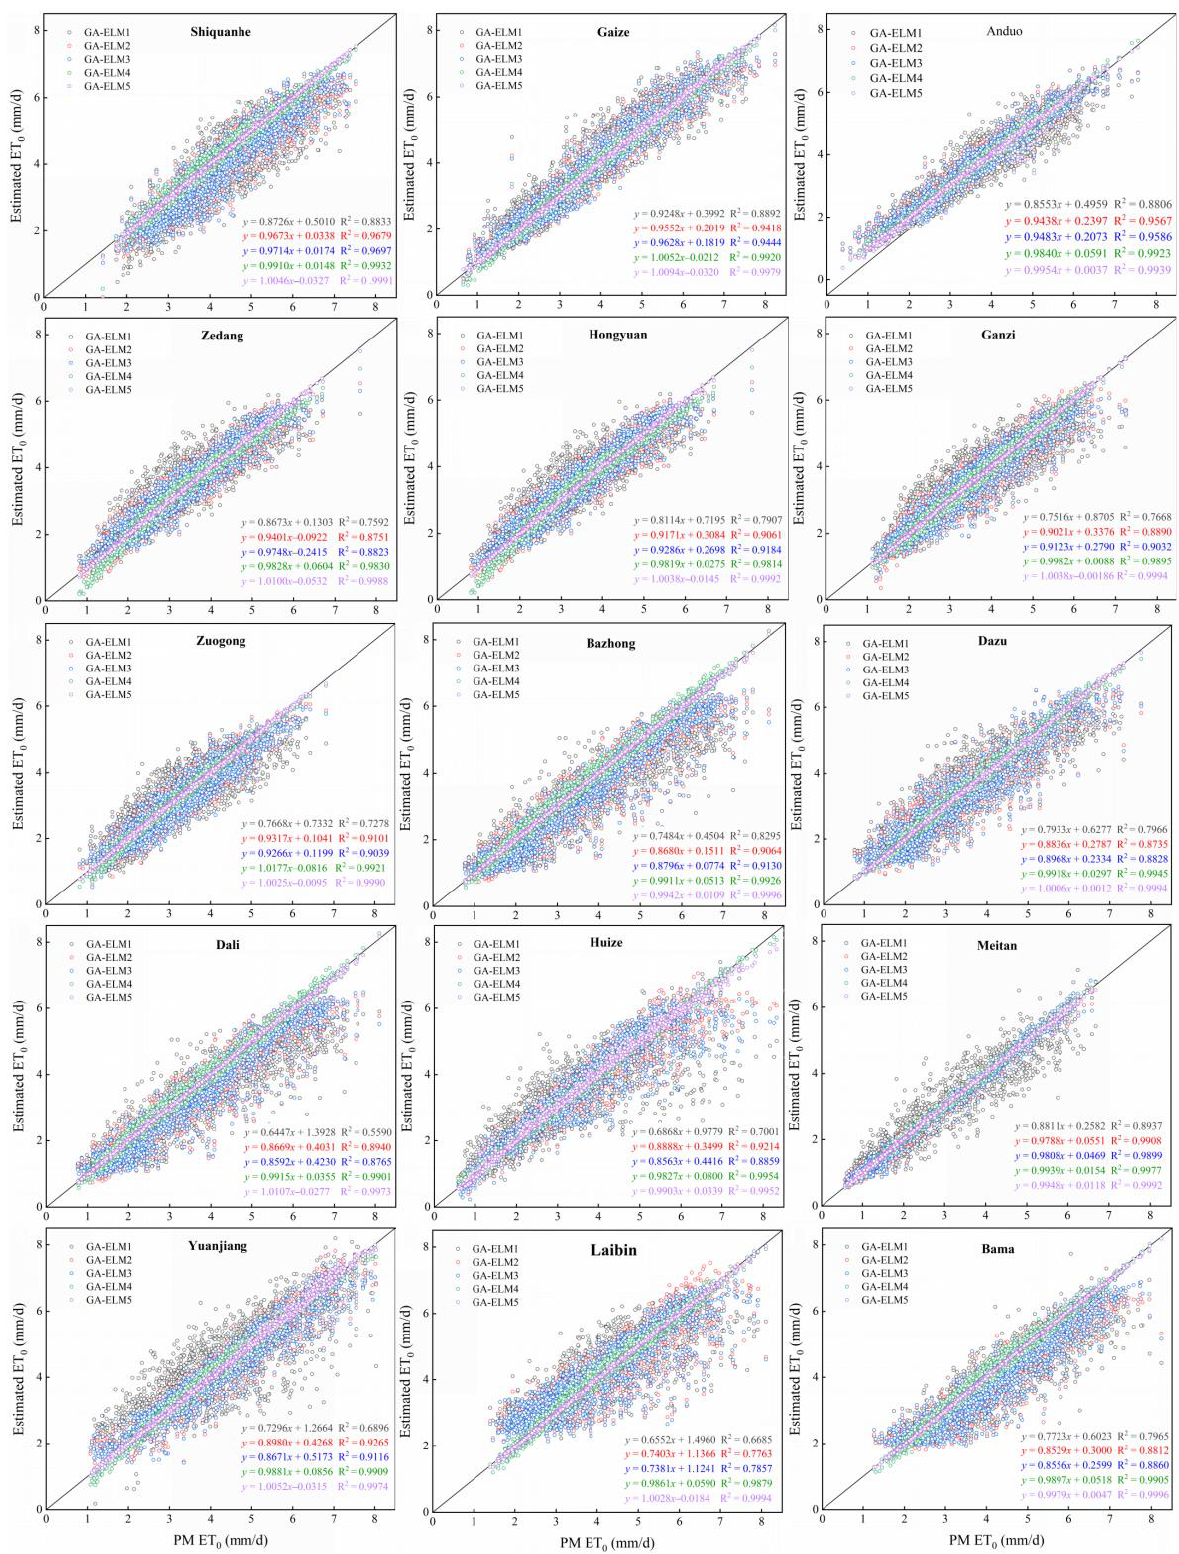
Figure 7. Scatter plots of predicted ET 0 values using GA-ELM models against their corresponding FAO56-PM values during testing in Southwest China. (Note: the fine line represents 1:1 line) .